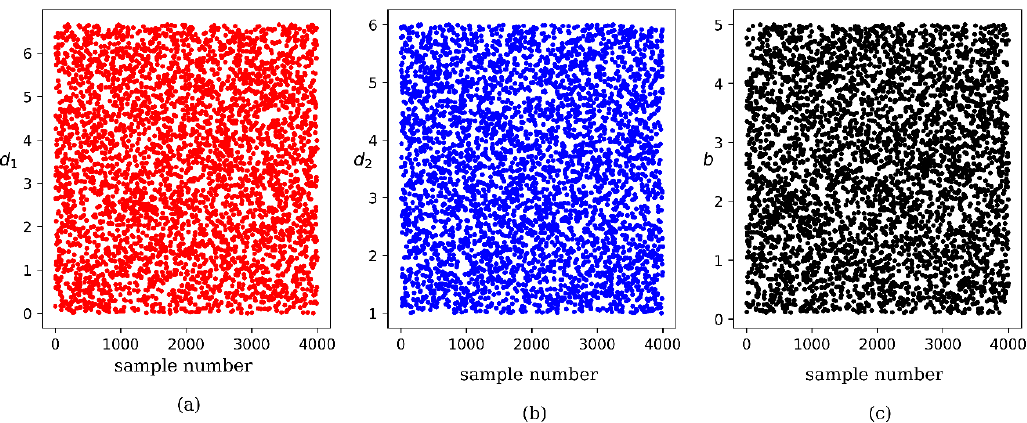
Figure 16. Dataset of design input feature for prediction: ( a ) barrier height, ( b ) submergence depth of a chamber wall, ( c ) barrier distance.